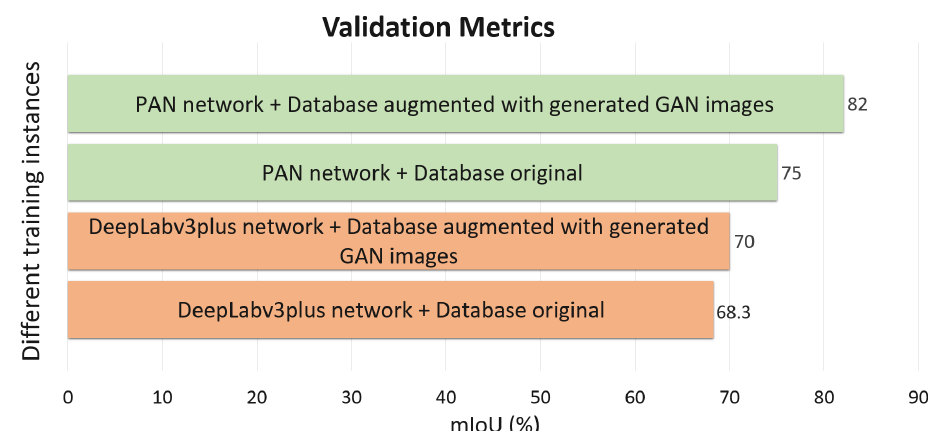
Figure 11. Mean of IoU (%) during evaluation with the original photometric-stereo RGB augmented database and the original one plus synthetic images generated by the GAN with a 38%